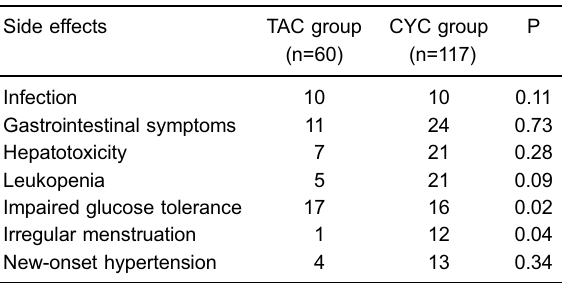
Table 3. Adverse effects in idiopathic membranous nephropathy patients treated with tacrolimus (TAC) or cyclophosphamide